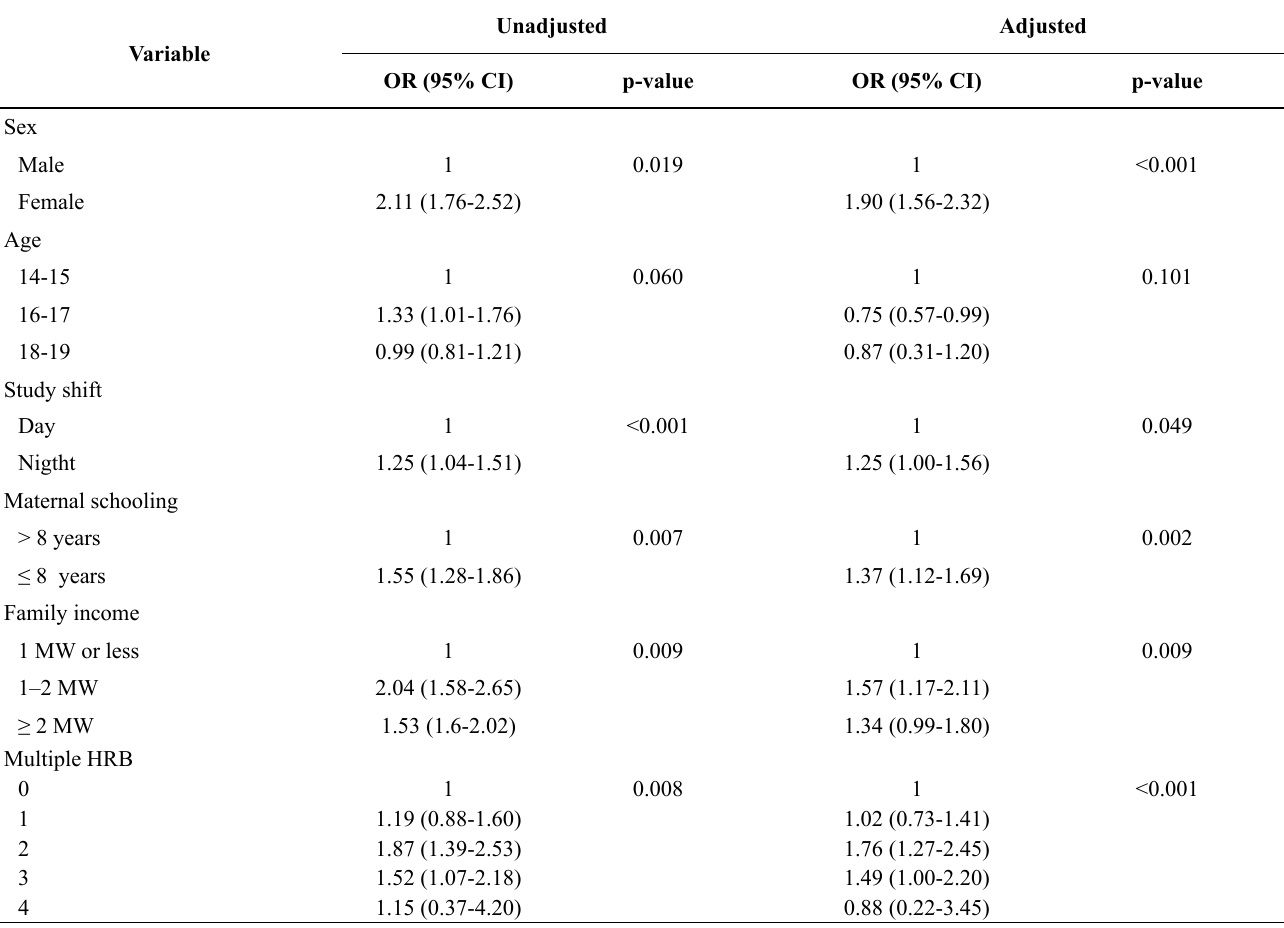
Table 3. Binary logistic regression to estimate the association of insufficient level of physical activity with multiple health risk behaviors in adolescents, Sergipe, Brazil,